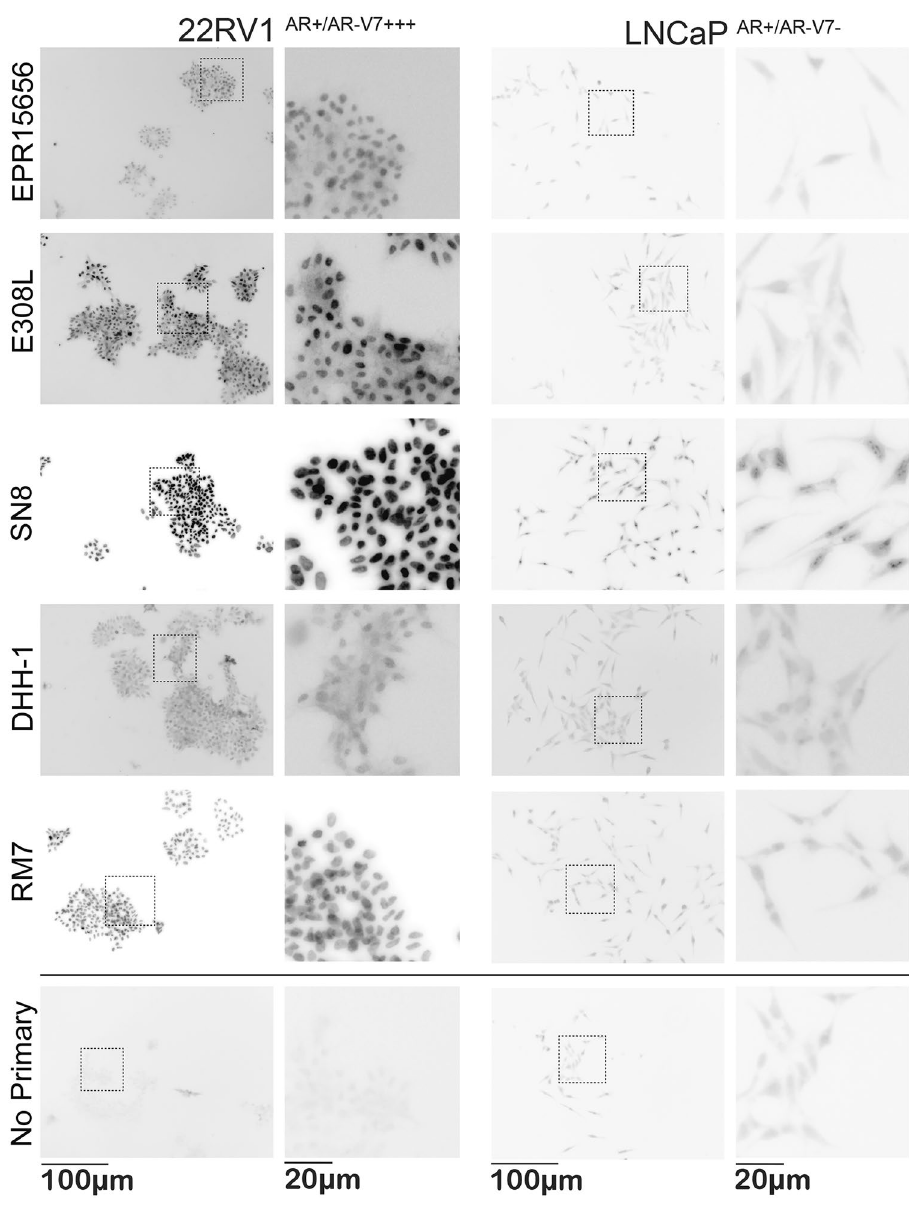
Figure 2. AR-V7 staining with different antibodies in AR-V7 positive and negative cells. Immunocytostaining was performed with the indicated antibodies on 22RV1 AR+/AR−V7+++ and LNCaP AR+/AR−V7− cells in comparison to no-primary antibody controls. Images were acquired with identical acquisition settings, with no pixel intensity saturation in the brightest cell labelling conditions. This enables quantitative comparison of intensity values across all antibodies and cell lines. Here, monochrome images are presented inverted, allowing easier visual detection of low intensity labelling patterns. Overview visual fields of stained cells are shown to the left with higher magnification images for representative regions (dotted boxes) to the